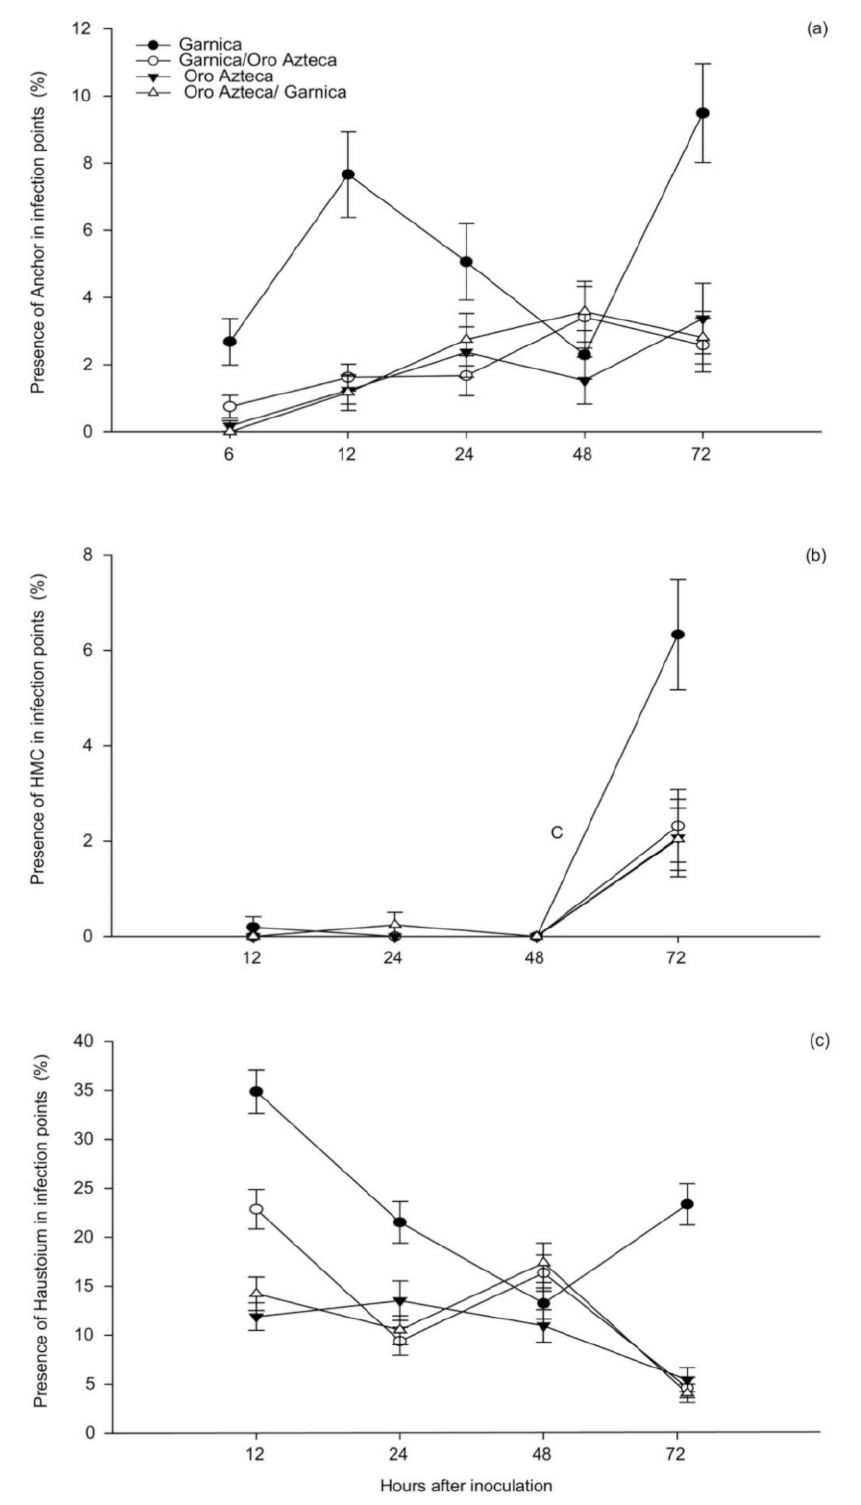
Figure 1. Presence of fungal structures. ( a ) Anchors, ( b ) haustorial mother cells (HMC) and ( c ) haustoria. The abundance was estimated as the percentage of infection points (stomatic chambers), in which the presence of fungal structures were observed in different periods sampled during 72 h after inoculation (hai) in grafted and ungrafted